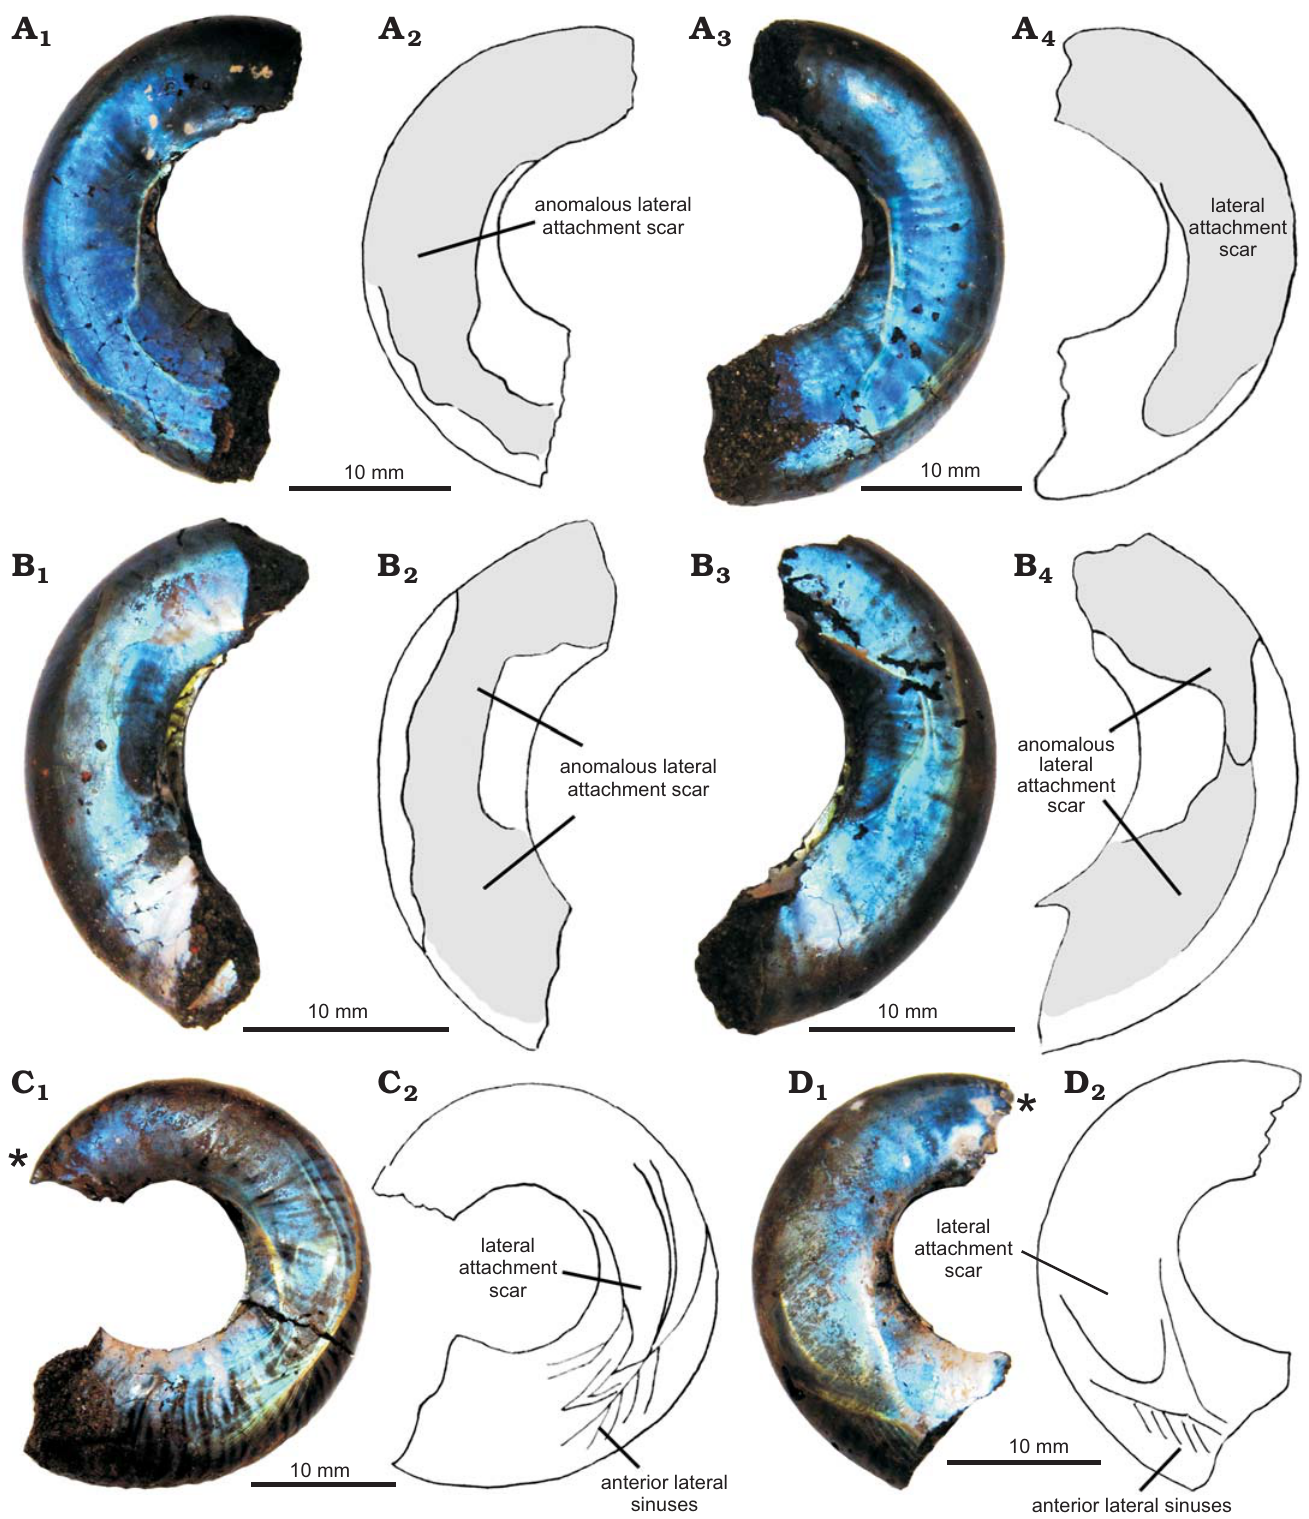
Fig. 8. Abnormal lateral attachment scars and lateral sinuses on Kachpurites fulgens (Trautschold, 1861) shells from Late Volgian ( Kachpurites fulgens Zone), Moscow region, Mnevniki locality. A . MSU 113/26, fragment of the body chamber with scars visible on both sides of the shell, normal shape scar (A , A ), anomalous scar-merged with anterior lateral sinuses (A 3 4 lateral sinuses on both sides of the shell. C . MSU 113/2, body chamber with abnormal scars merged with lateral sinuses. The apertural part is not preserved. D . MSU 113/16, posterior part of body chamber. Visible two growth stages of scars: a later-formed with a sharp-edged border and an earlier-formed rounded inside the first one. Asterisks mark the base of the body chamber. Photographs (A